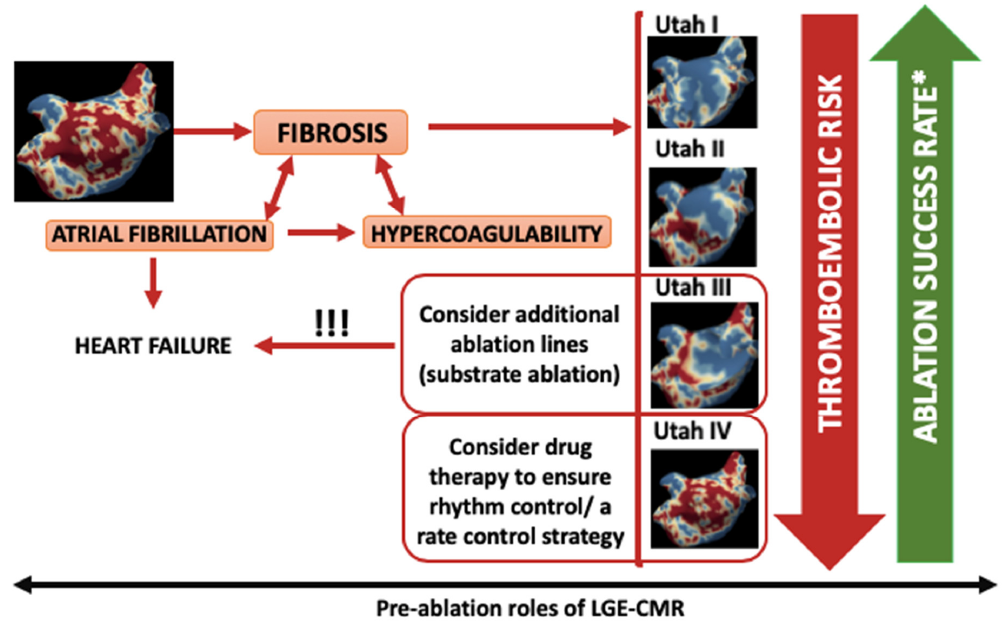
Figure 3. Roles of LGE-CMR.* in terms of immediate sinus rhythm restoration and post-procedural Figure 3. Pre-ablation roles of LGE-CMR.* in terms of immediate sinus rhythm restoration and arrhythmia recurrences. LA: left atrium; LGE-CMR: late-gadolinium enhancement cardiac magnetic post-procedural arrhythmia recurrences. LA: left atrium; LGE-CMR: late-gadolinium enhancement resonance, Utah classes of fibrosis: Utah I: <10%, Utah II: 10%–20%, Utah III: 20%–30%, Utah IV: cardiac magnetic resonance, Utah classes of fibrosis: Utah I: < 10%, Utah II: 10%–20%, Utah III: 20%–30%, >30%. Utah IV: >